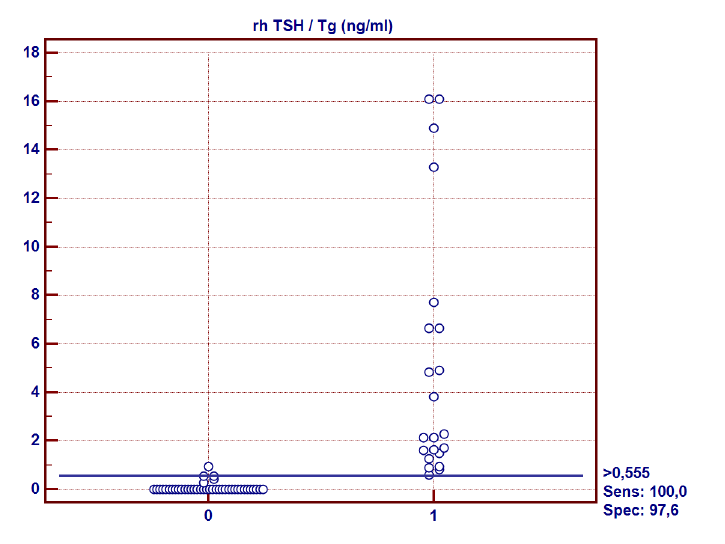
Fig 2. Recombinant human thyrotropin-stimulated thyroglobulin (rhTSH/Tg) sensitivity and specificity for cut-off level > 0.6 ng/ml. 0-Group of patients with thyroid hormone withdrawal-stimulated thyroglobulin (THW/Tg) < 2 ng/ml 1-Group of patients with thyroid hormone withdrawal-stimulated thyroglobulin (THW/Tg) (cid:1) 2 ng/ml